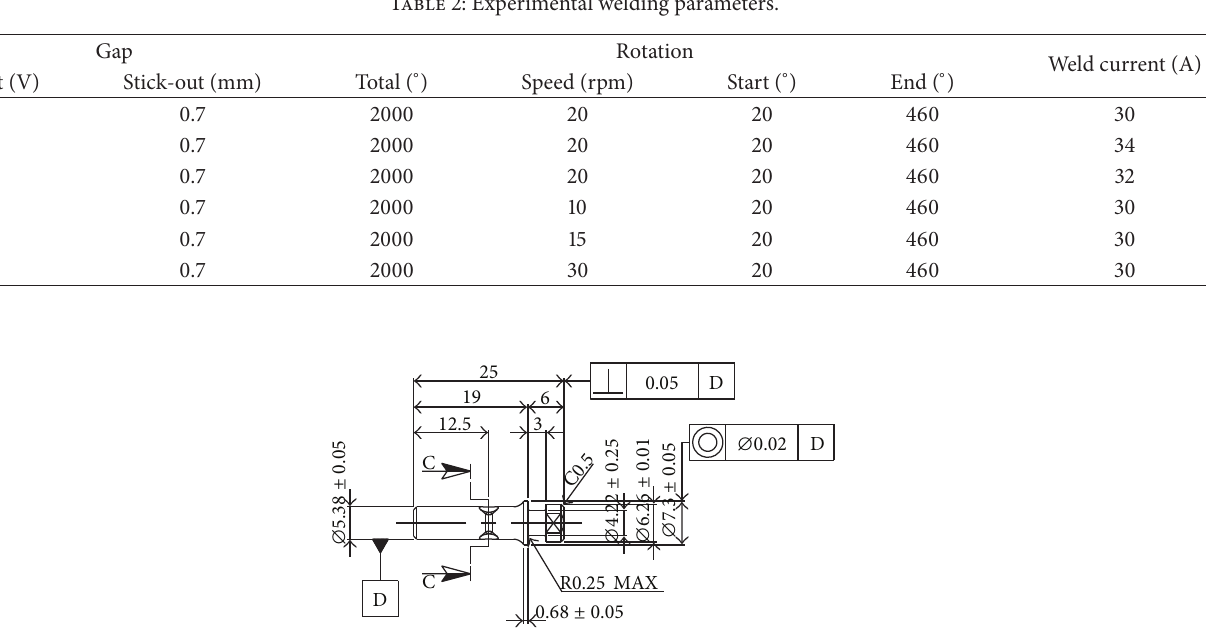
Table 2: Experimental welding parameters.